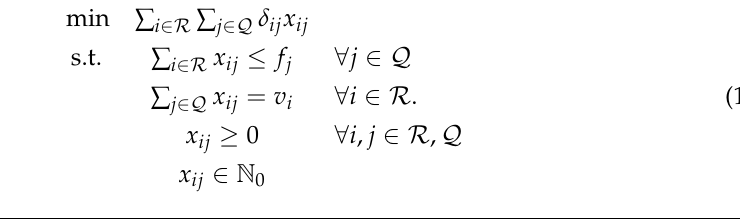
Algorithm 1 Parking Operating Policy 1: Diffusion